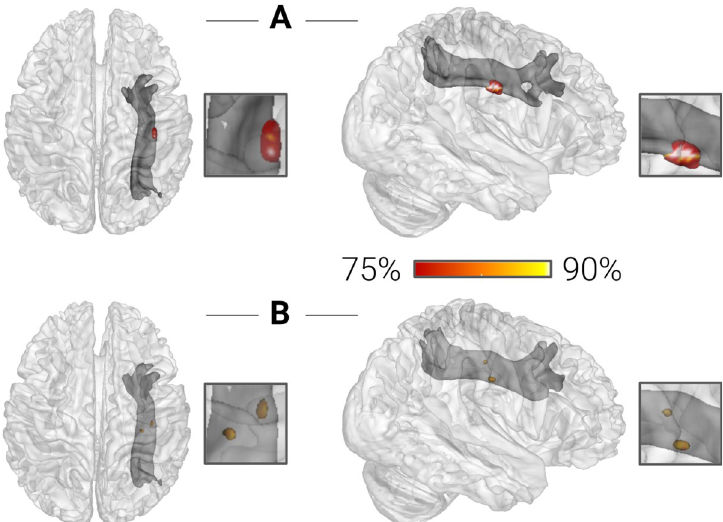
Fig 4. Structural connectivity classification results. The color bar indicates the peak accuracy for the classification of children with dyscalculia versus typical controls ( P < 0.001, corrected by permutation testing) based on the structural connectivity (streamline density) of the right SLF connecting the right PPC and the right DLPFC. The numerical data used in this figure are included in S4 Data. DLPFC, dorsolateral prefrontal cortex; PPC, posterior parietal cortex; SLF, superior longitudinal fasciculus.